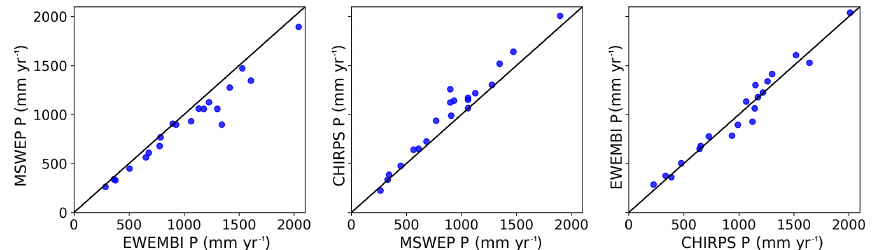
Figure 5. Comparison of the EWEMBI, MSWEP and CHIRPS precipitation products with respect to their prediction of mean P across the basins.